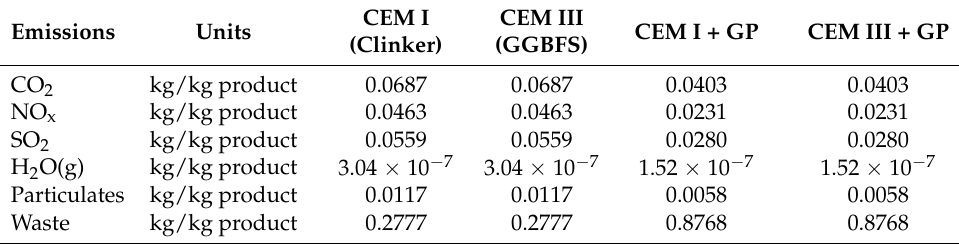
Table 6. General emissions inventory input and